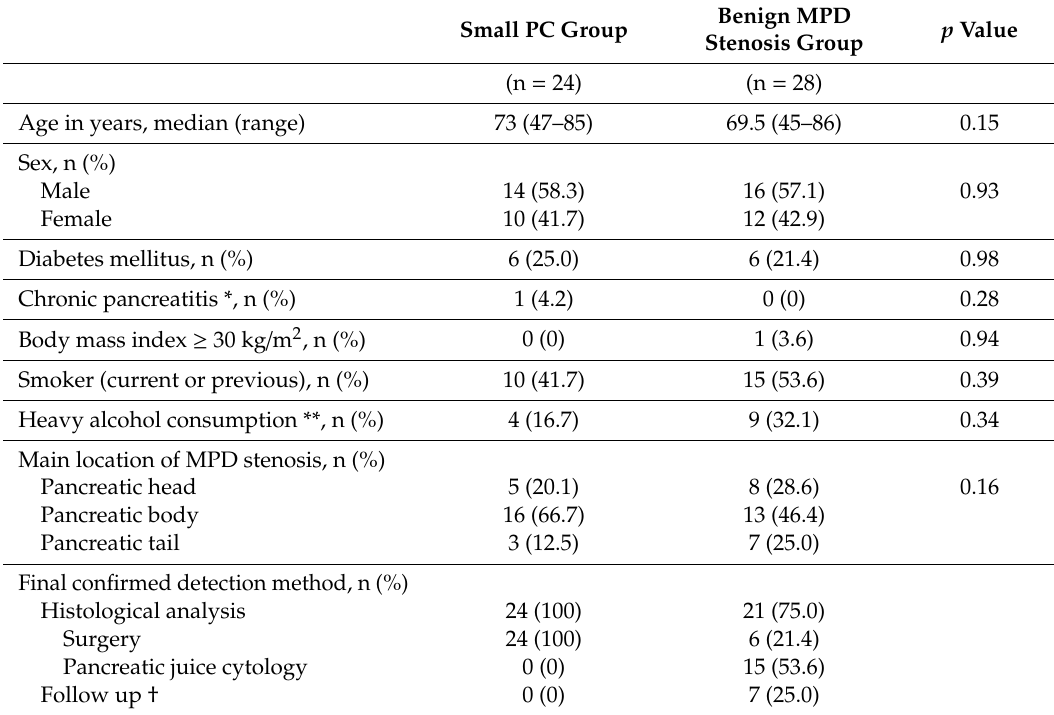
Table 1. Patient demographic and clinical